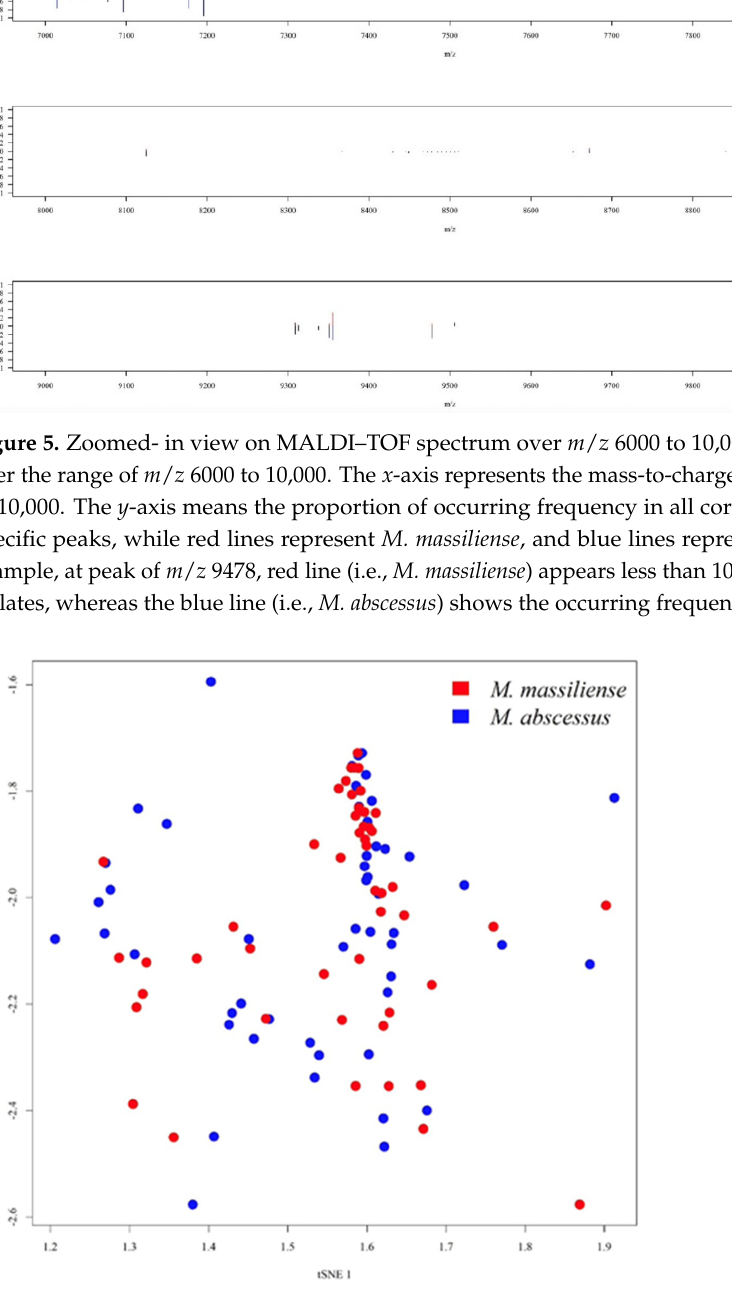
Figure 6. Visual illustration of MS spectrum data onto a two-dimensional plot. MALDI–TOF MS spectra of the two different MABC subspecies are analyzed and depicted on a two-dimensional plot. No obvious clustering or patterns can be observed based on the distribution of data